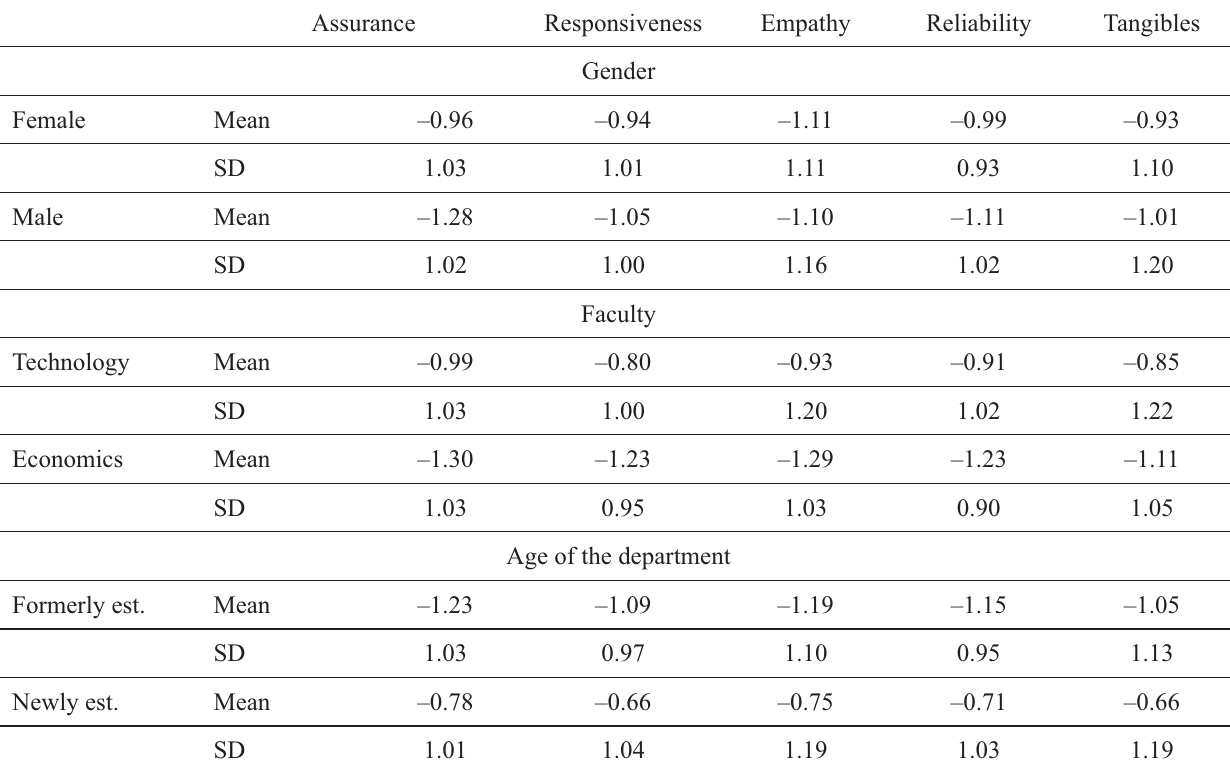
Table 6. The SERVQUAL dimensions scores for segments of